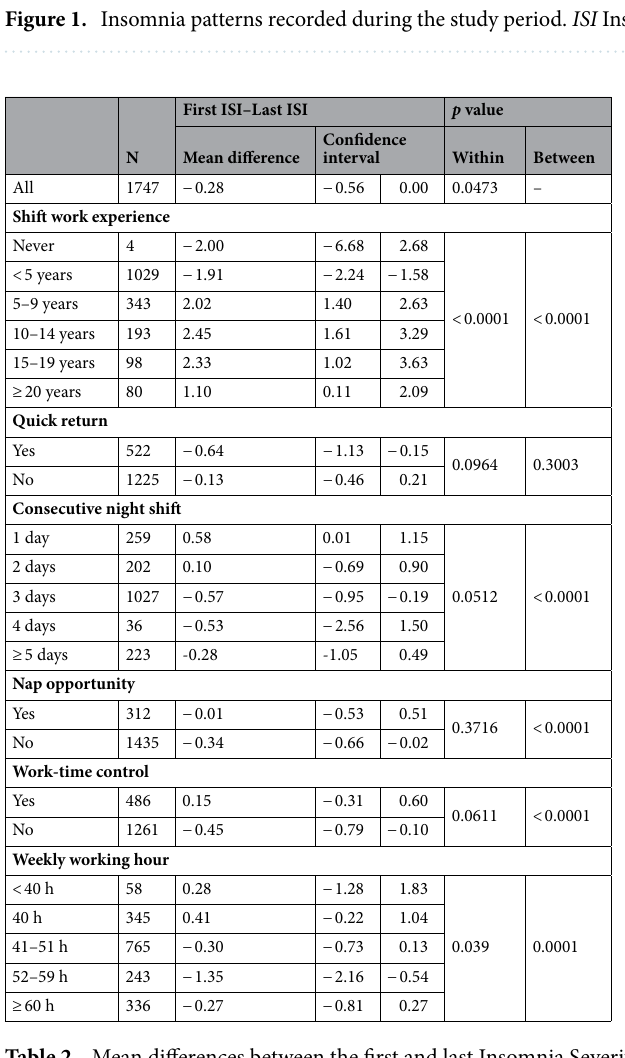
Table 2. Mean differences between the first and last Insomnia Severity Index scores stratified according to work